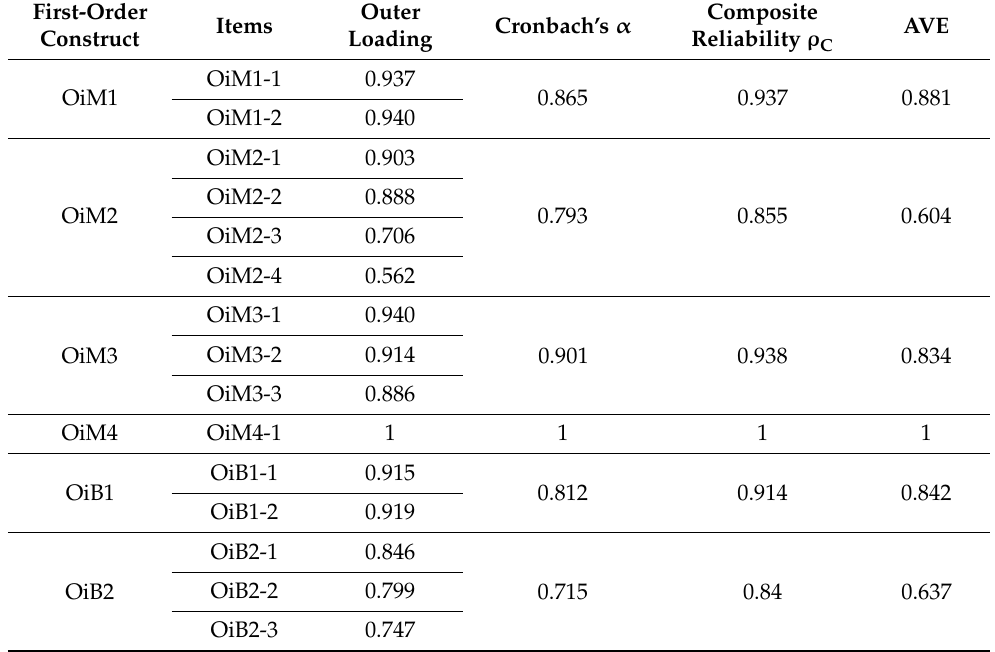
Table 2. Reliability and validity assessment of the first-order